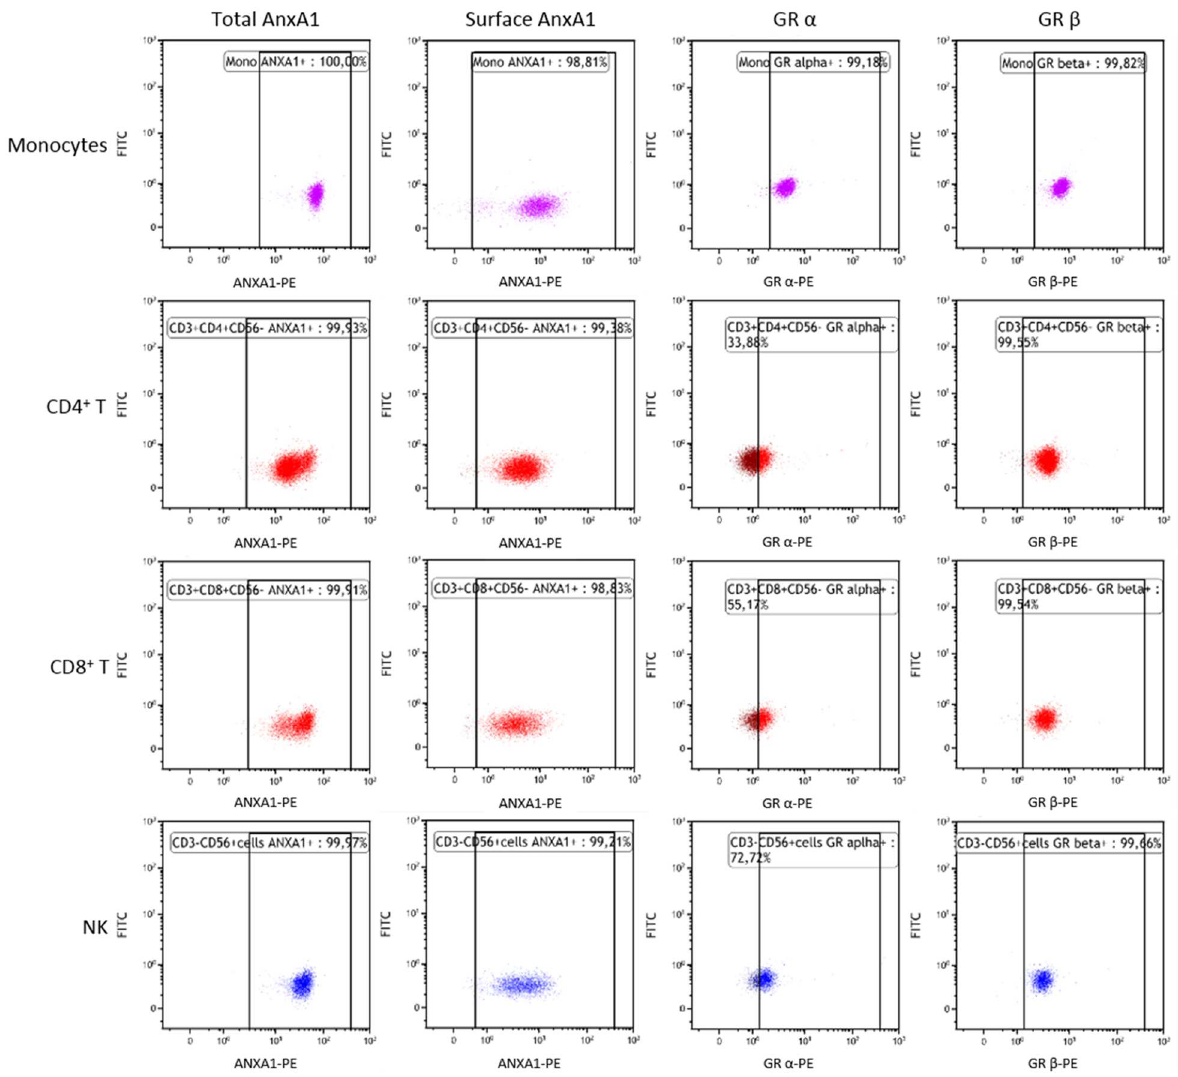
Fig 2. Representative examples of dot plots. The figure shows expressionof total AnxA1, surface-bound AnxA1, GR-alpha and GR- beta, respectively(from left to right) for monocytes, CD4 + T cells, CD8 + T cells, and NK cells (from top to bottom).